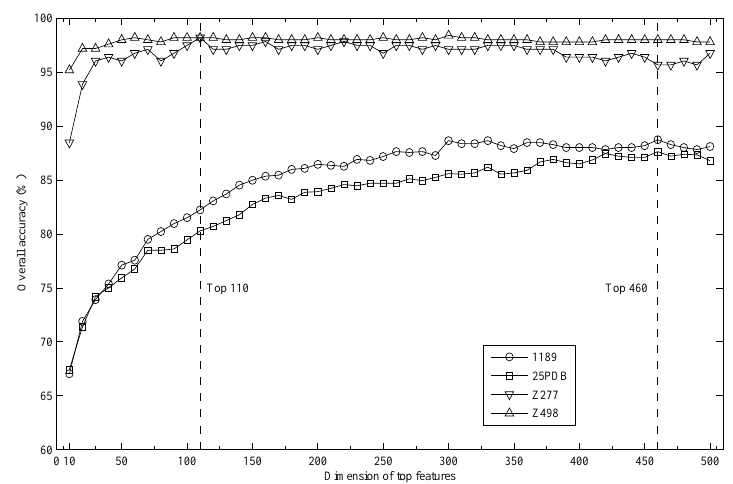
Figure 1. This graph shows how different top K features affect the overall accuracies.